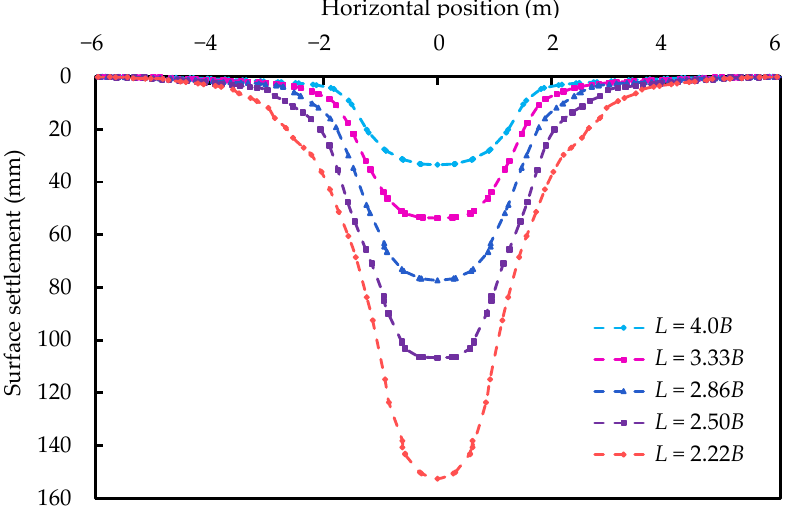
Figure 13. Vertical displacement of the surface of the soil for different subsidence widths.